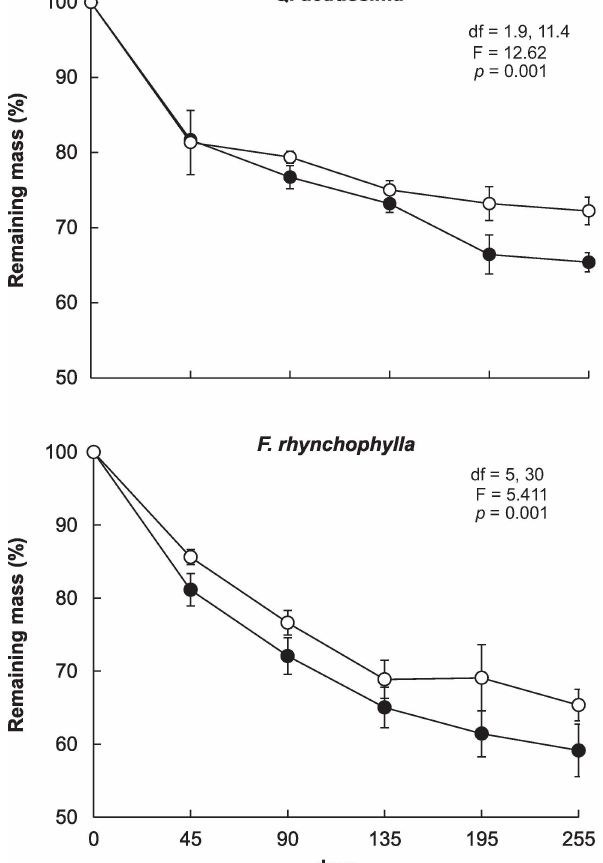
Fig 1. Changes in the remaining mass of the Q . acutissima (upper) and F . rhynchophylla (lower) leaf litter in the microcosms. Closedcircles represent leaf litter obtainedfrom the ambientair (380 ppm CO 2 ) chamber, and open circles representthat collectedfrom the elevatedCO 2 (700 ppm) chamber. Bars show standarddeviations(n =